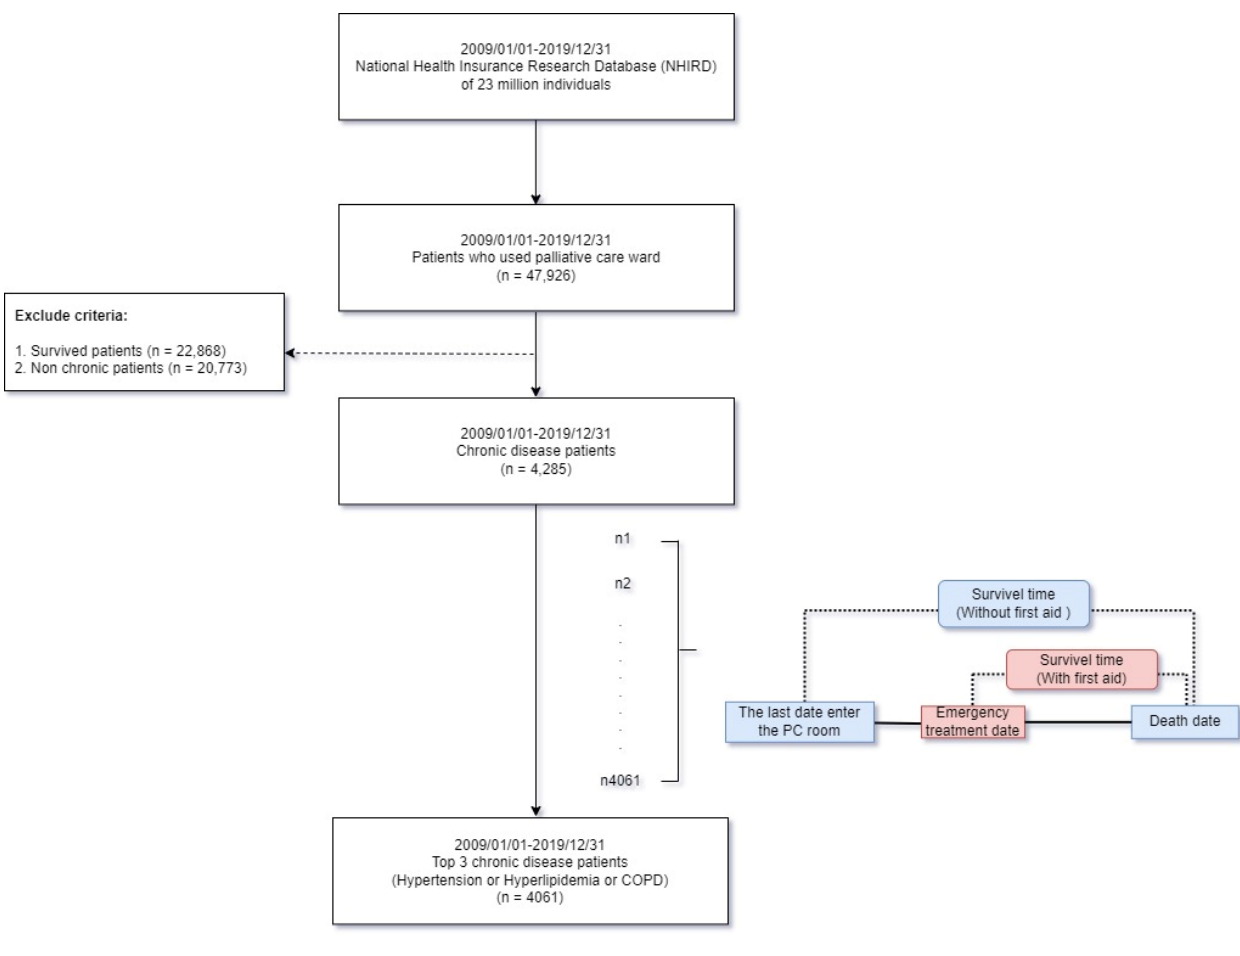
Figure 1. Selection